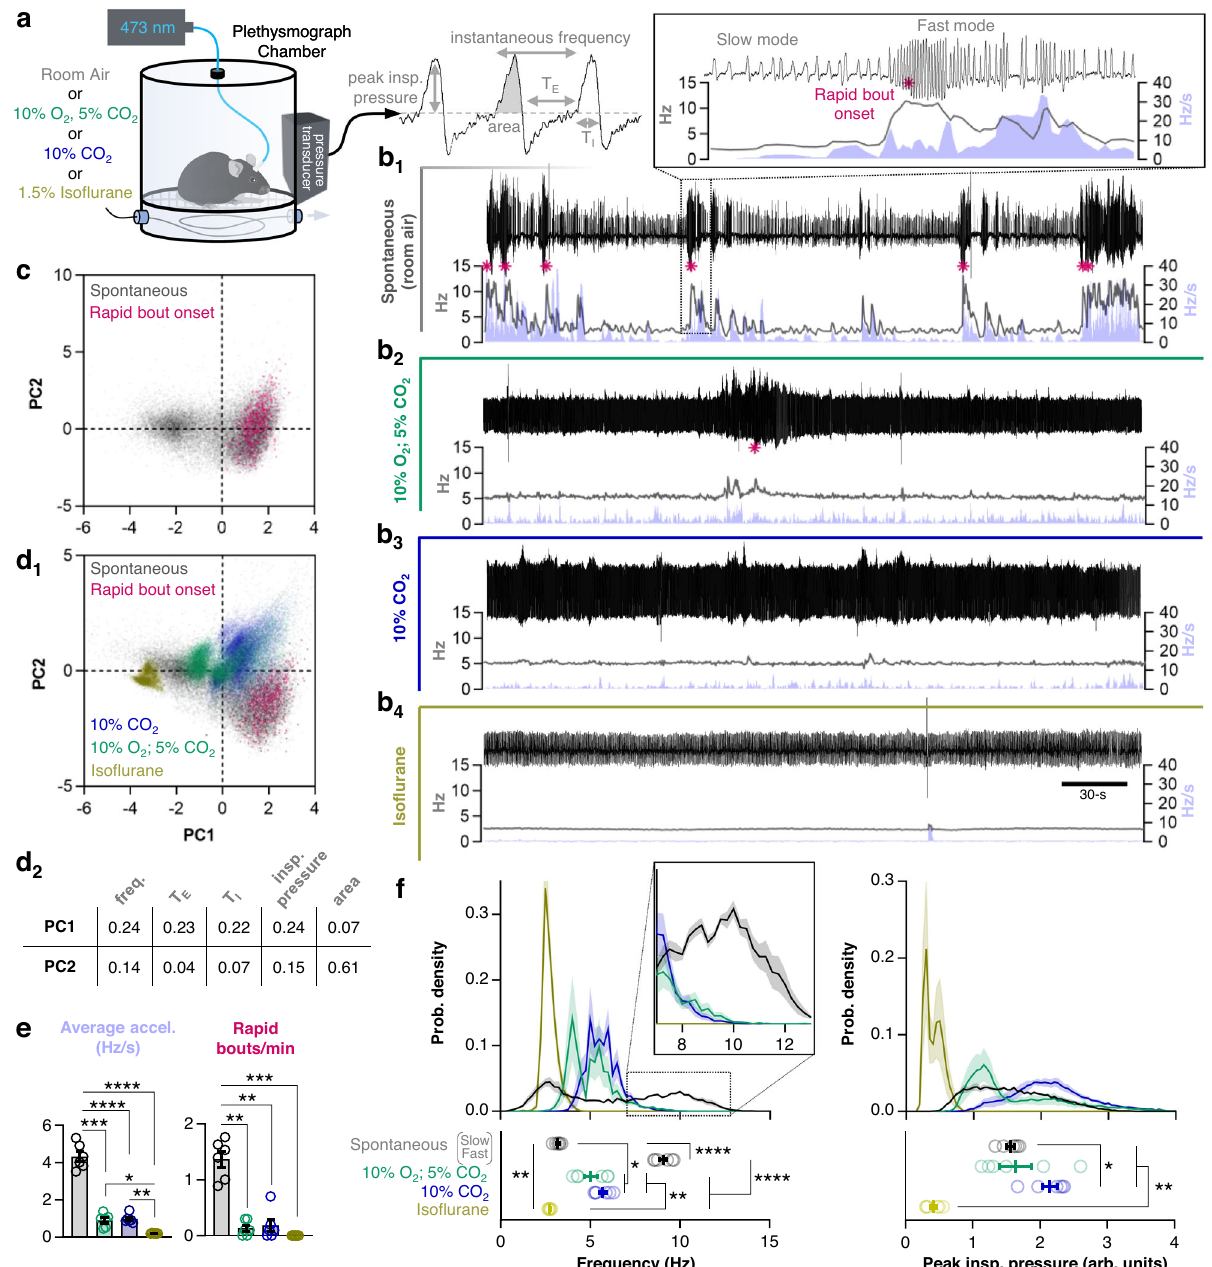
Peak insp. pressure (arb. units) breathing patterns (d 1 ; 67,579 breaths from n =6 mice) and relative contributions of respiratory parameters to PCs 1 and 2 (D 2 ). e Quanti fi ed average acceleration (left) and number of rapid breathing bouts per minute (right). n =6; one-way RM ANOVA with Tukey ’ s multiple comparisons tests. f Probability density histograms (top) and mean values from each mouse ( n =6; bottom) comparing breathing frequencies (left) and peak inspiratory pressures (right) during each condition. Inset illustrates the rapid breathing frequencies (~8 – 12Hz) that characterize the awake spontaneously breathing state. Breathing frequencies under spontaneous conditions were bimodal and were separated into “ slow ” and “ fast ” modes for analysis. One-way RM ANOVA with Tukey ’ s multiple comparisons tests. * p <0.05; ** p <0.01; *** p <0.001; **** p <0.0001. Means±SE. Source data are provided as a Source Data fi